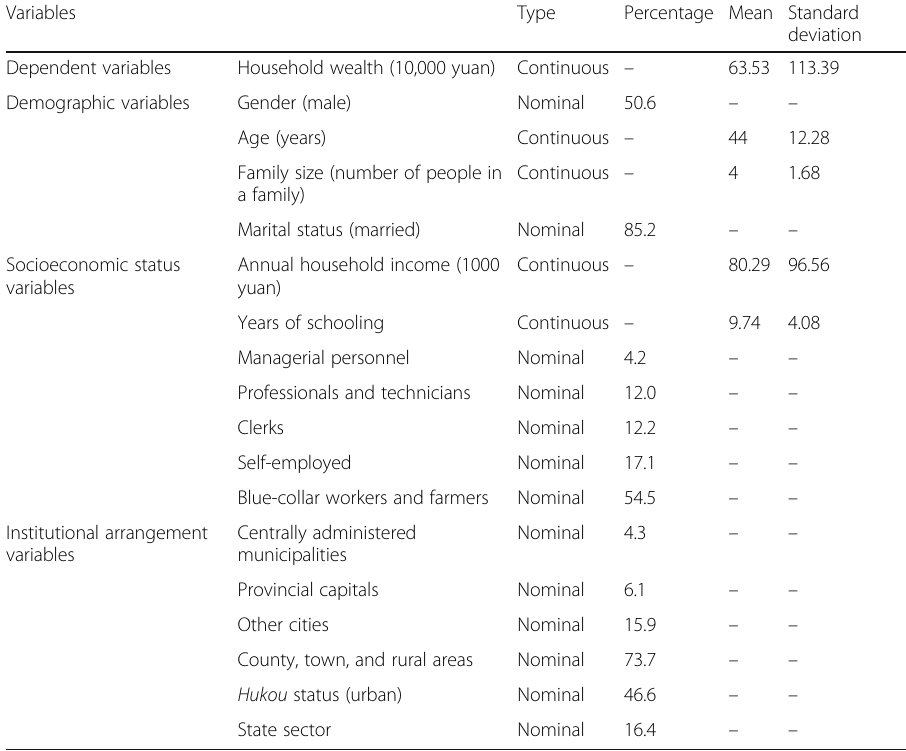
Table 1 Descriptive statistics of variables (2017, urban residents, N = 5,165)